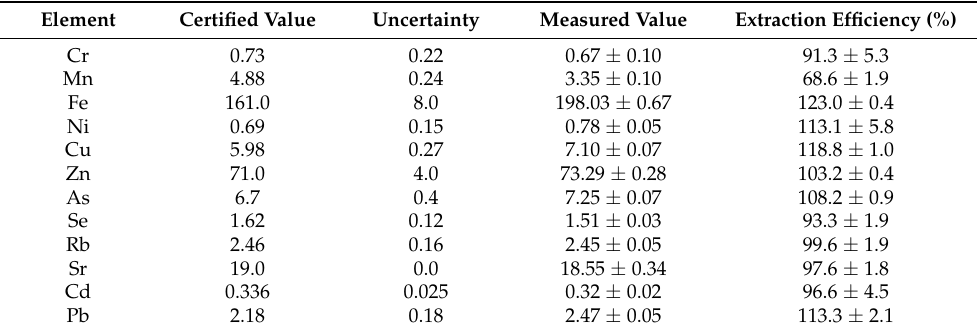
Table 1. Fish muscle (ERM-BB422) certified and analyzed elemental values, uncertainty (mg/Kg) and calculated extraction efficiencies (average ± standard deviation, N =